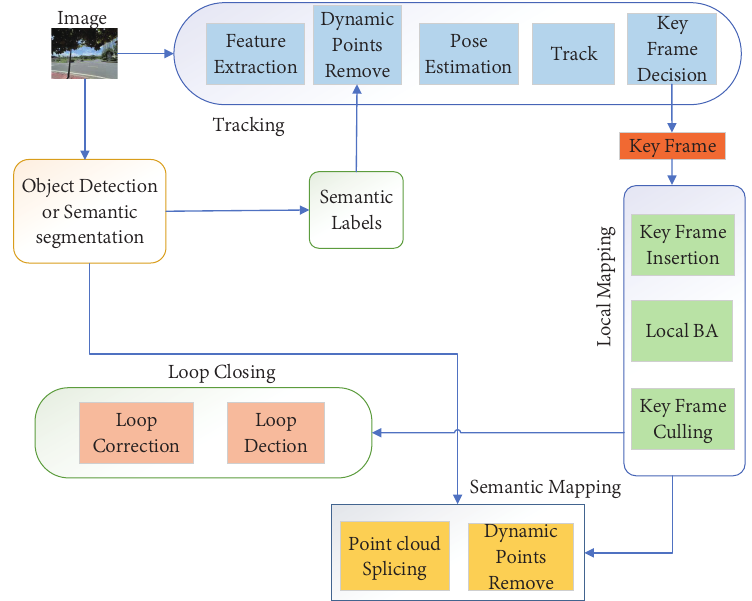
Figure 24. Typical dynamic object removal